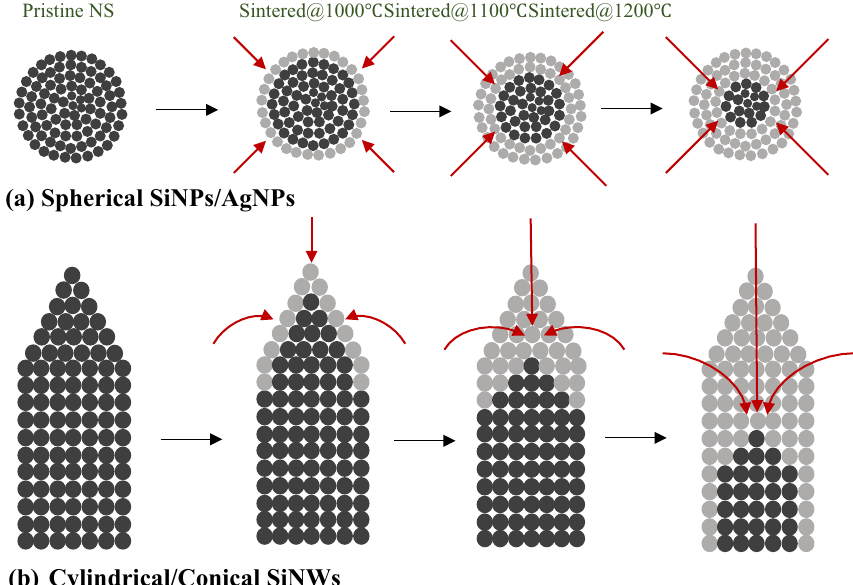
Figure 8. Schematic surface melting phenomena occur during sintering ( a ) spherical NPs ( b ) conical/ cylindrical SiNWs. The black color-filled circle represents the atoms present in the NWs. The grey color-filled circle represents melted atoms after sintering. The dark-red color arrow indicates the surface melting path in the spherical or cylindrical